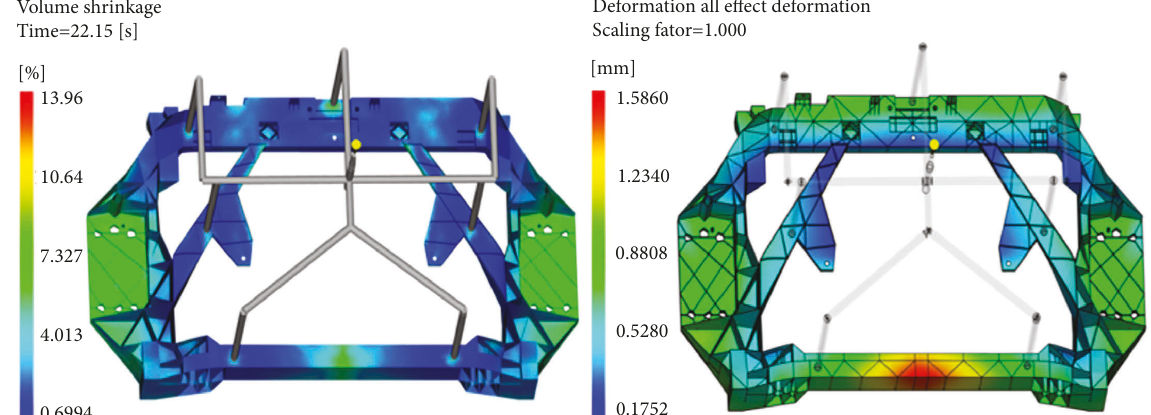
Figure 9: Volume shrinkage and warpage analysis results of the 7 gate gating systems.